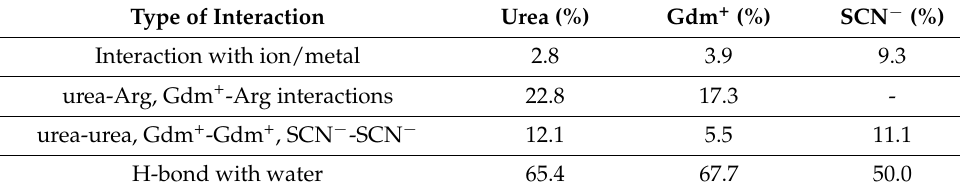
Figure 2. Binding site of the Sporosarcina pasteurii urease protein (PDB ID: 6qdy [35]) where urea makes the largest number of contacts. Hydrogen bonds with main and side chains of both aliphatic and hydrophobic amino acids, nonpolar interactions with protein atoms as well as with ions stabi- lize urea (URE611) in the present binding site. Yellow and cyan sticks represent aliphatic and aro- matic van der Waals-type contacts, respectively. 3.2. Insights into Urea-Protein Interactions Inspection of Table 1 indicates that urea frequently interacts with its partners by mak- ing H-bonds. This is not surprising as this molecule is endowed with groups that can act as hydrogen acceptors or donors in this type of interaction. This dual possibility to form